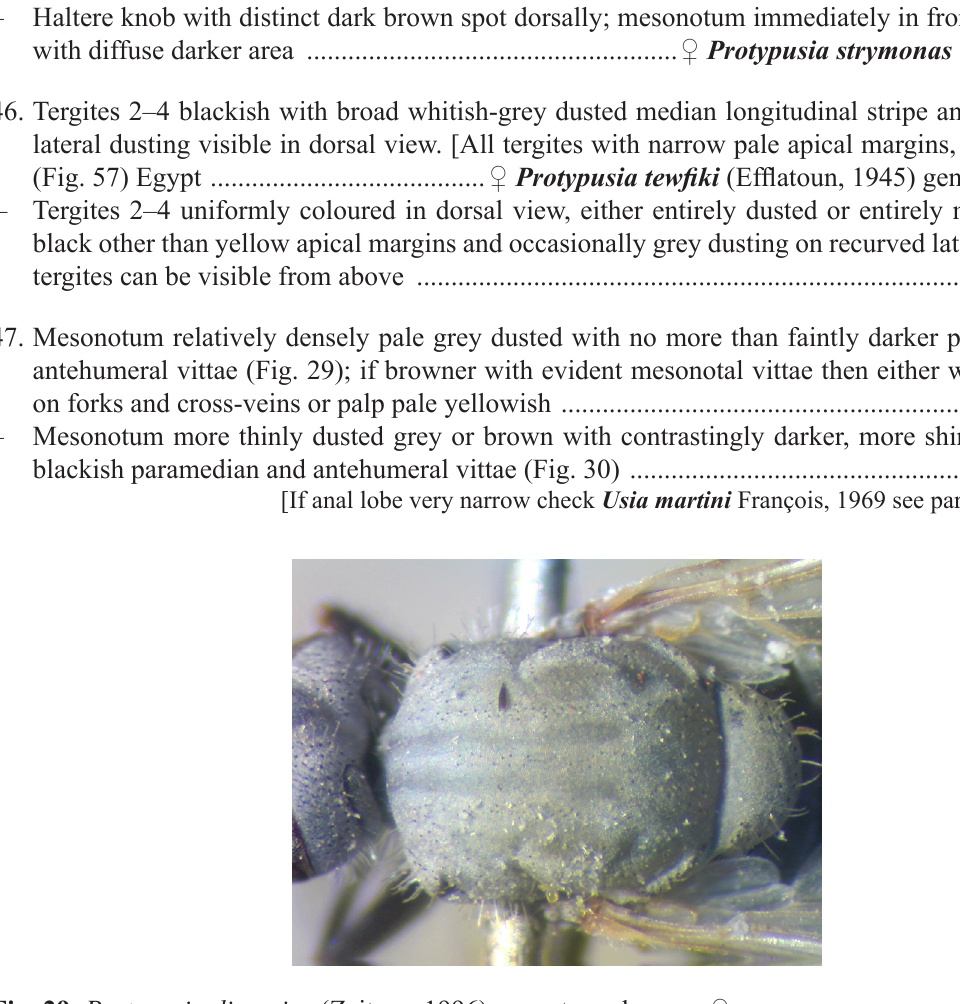
Fig. 29. Protypusia dimonica (Zaitzev, 1996) gen. et comb. nov., ♀.